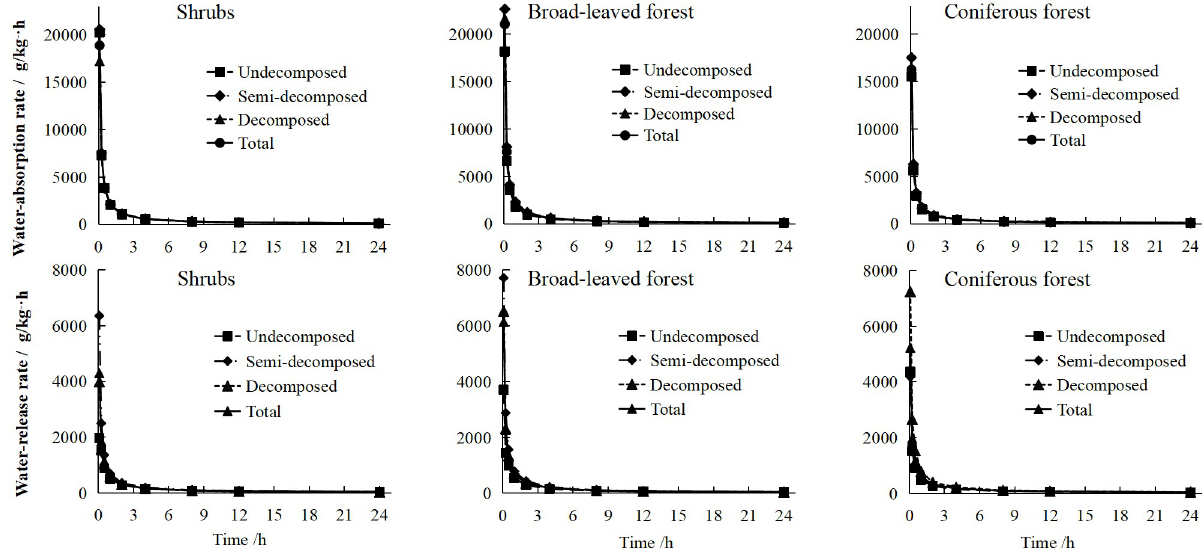
Fig 8. The litter water-absorption/release rate characteristics (g/kg �